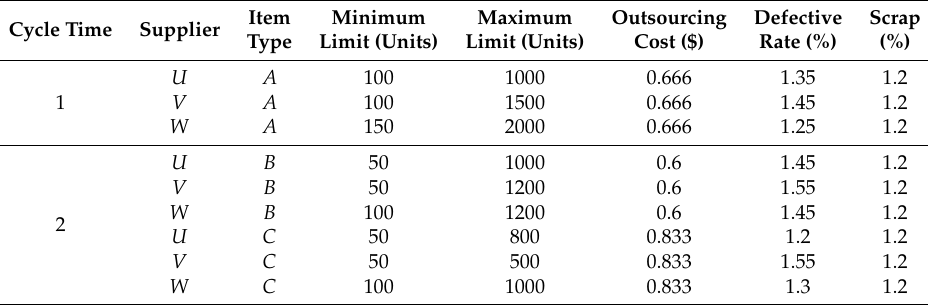
Table 8. Outsourcing